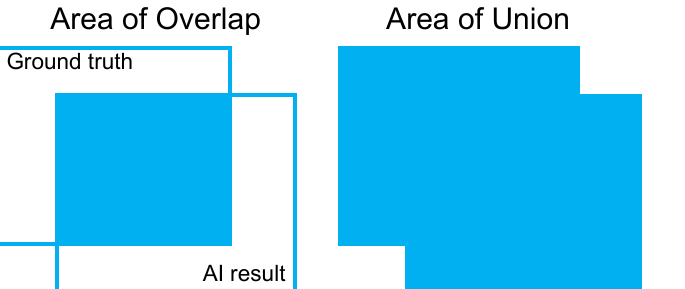
Figure 2. Area of overlap and union between the ground truth and AI result. Area of overlap indicates the common part of the area of the ground truth and AI result; area of union indicates the union set of the area of the ground truth and AI result.